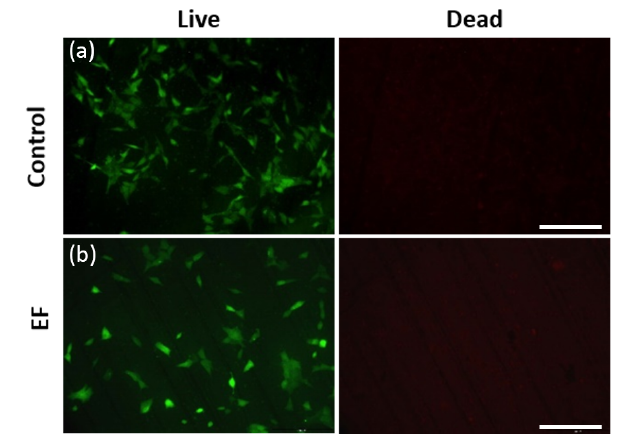
Figure 2. Illustration of the cells after 120min on the device for (a) control and (b) EF stimulation. The green stain indicates viable cells, while red indicates non-viable. Scale bar